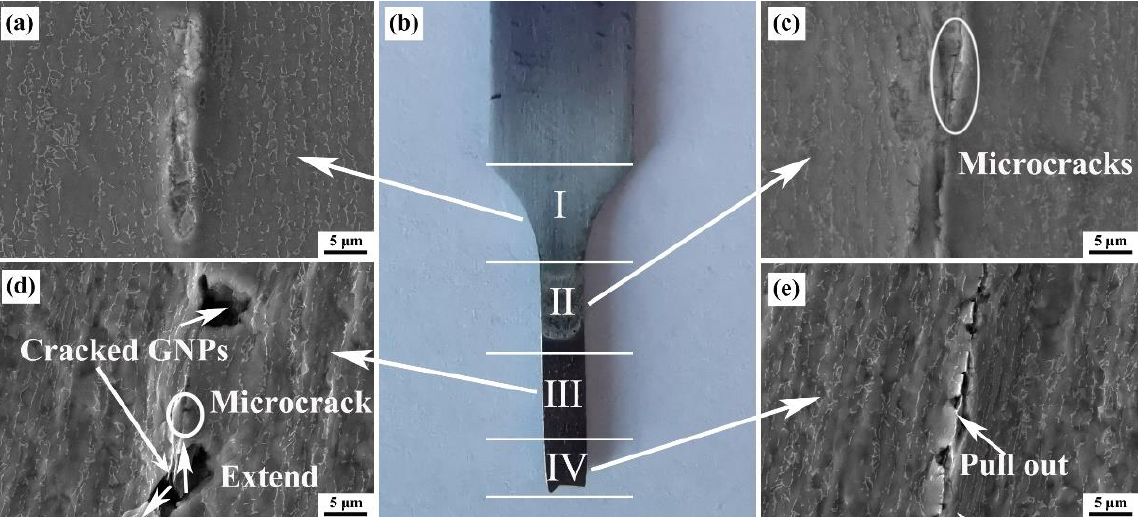
Figure 2. The side fracture specimen of GNPs/TA15 composites ( b ); SEM images with different locations ( a , c – e ).